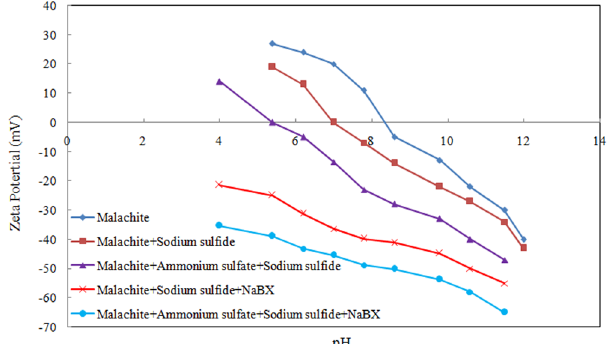
Figure 2. Zeta potentials of malachite as a function of pH in the absence or presence of Na 2 S, (NH 4 ) 2 SO 4 , and